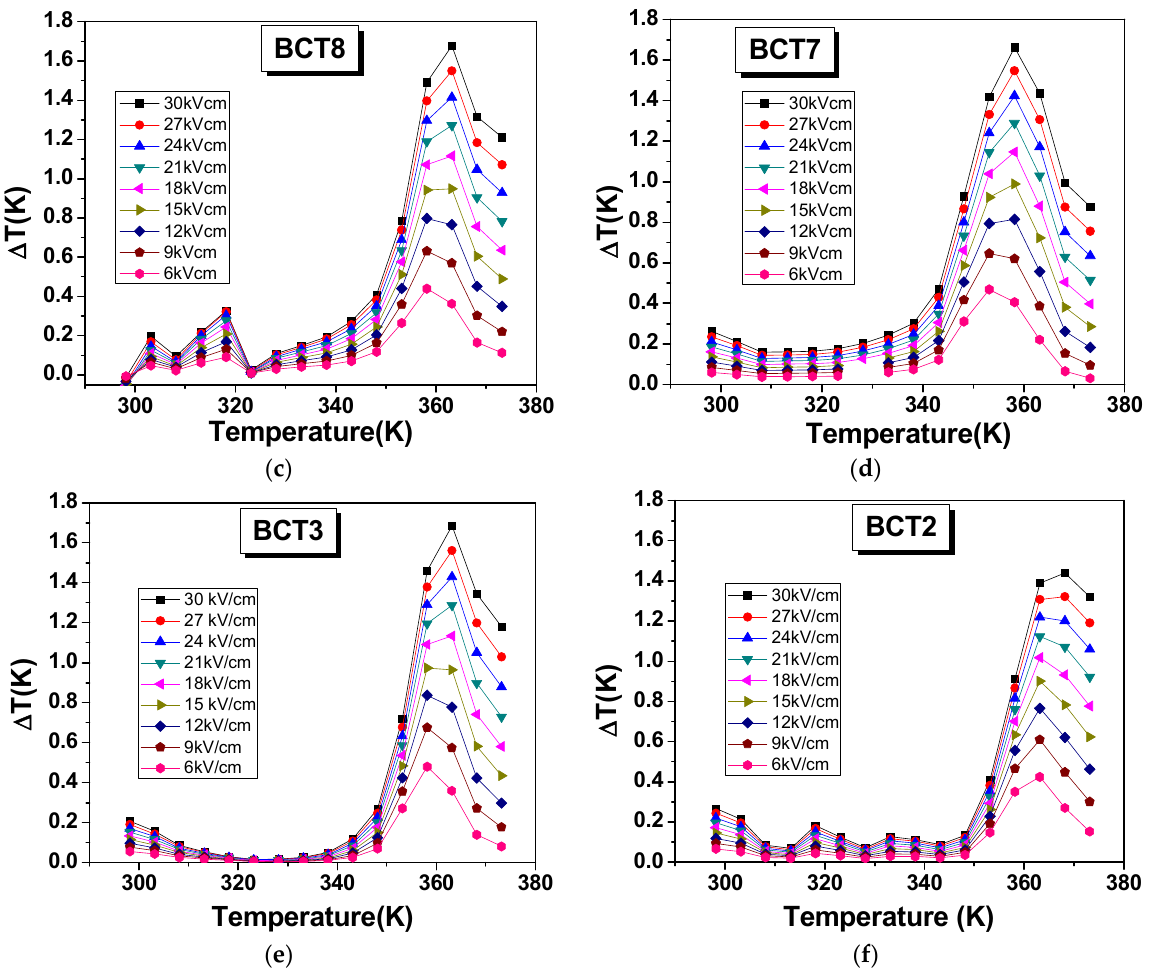
Materials 2022 , 15 , x FOR PEER REVIEW 9 of 11